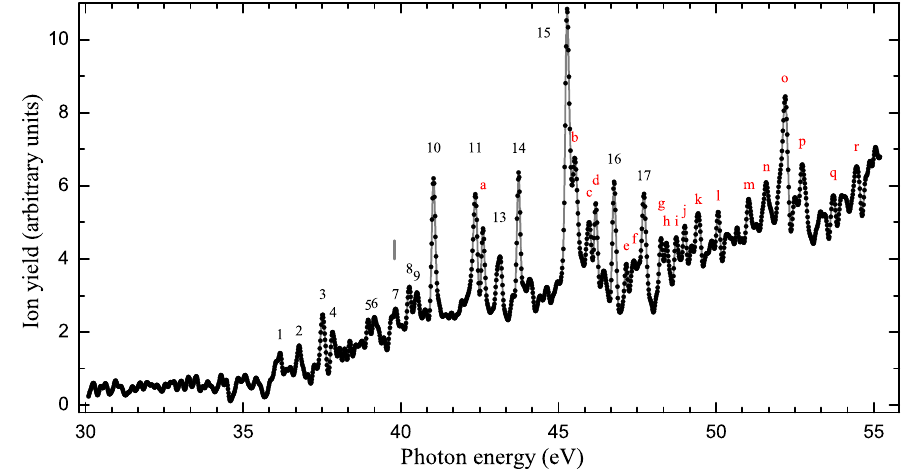
Figure 1. (Color online) Single-photon photoionization ion-yield spectrum of Cl III into Cl IV measured with a photon energy resolution of 10 meV. Measured data are (black) dots joined by a straight line. The vertical line (gray) corresponds to the ionization limit of 39.80 eV. Alpha (red) and numeric labels correspond to some of the most well-defined and prominent peaks listed in Tables 2 and 3. Labeling was arbitrarily chosen to improve